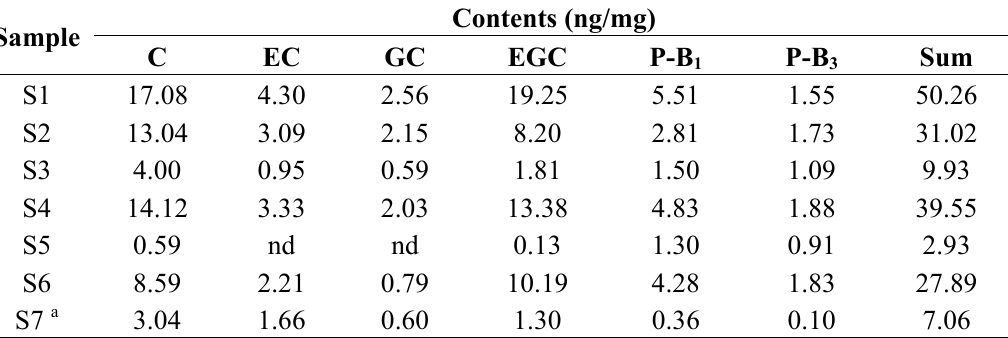
Table 5. Catechin and procyanidin contents of the extracts ( n = 2).